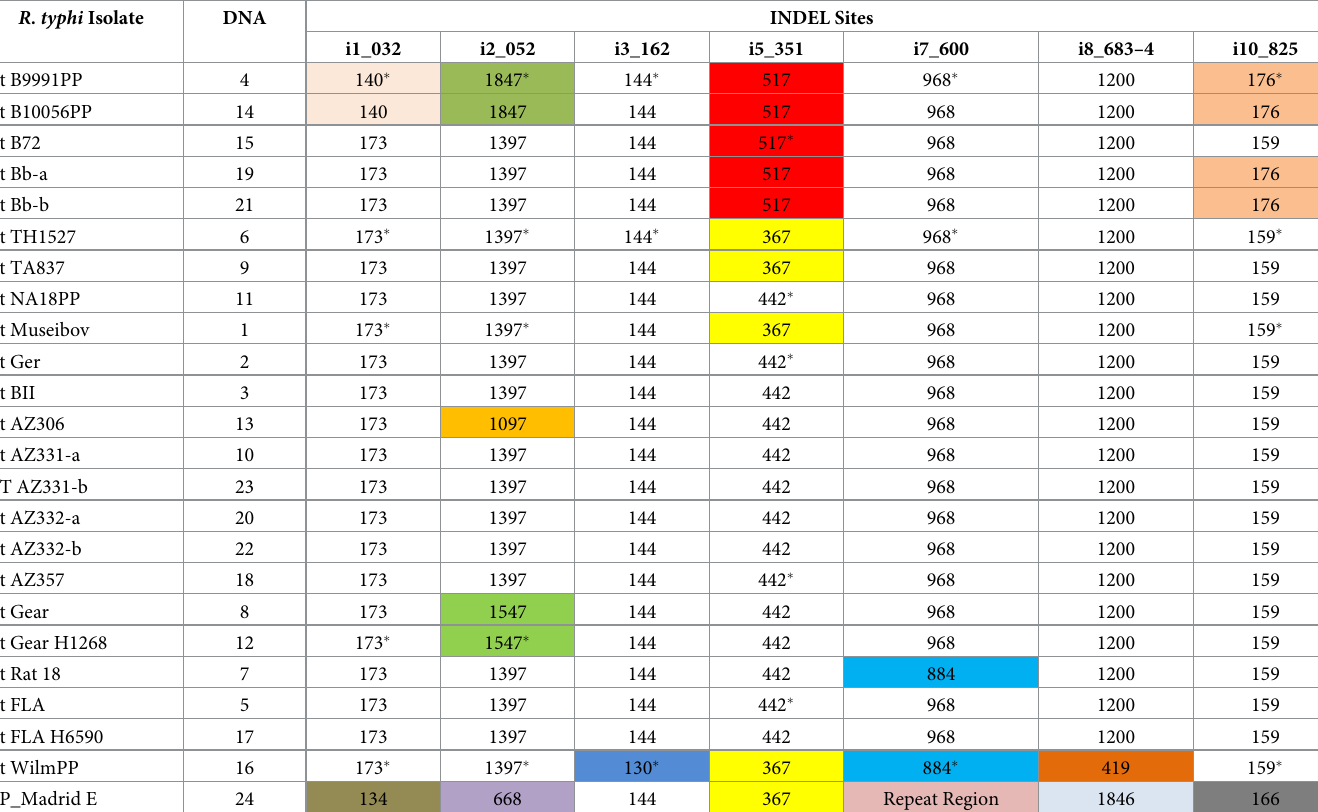
Table 2. Summary of INDEL site analyses ( � sizes confirmed by sequencing, colored cells have variable size polymorphisms at that locus). R . typhi Isolate DNA INDEL